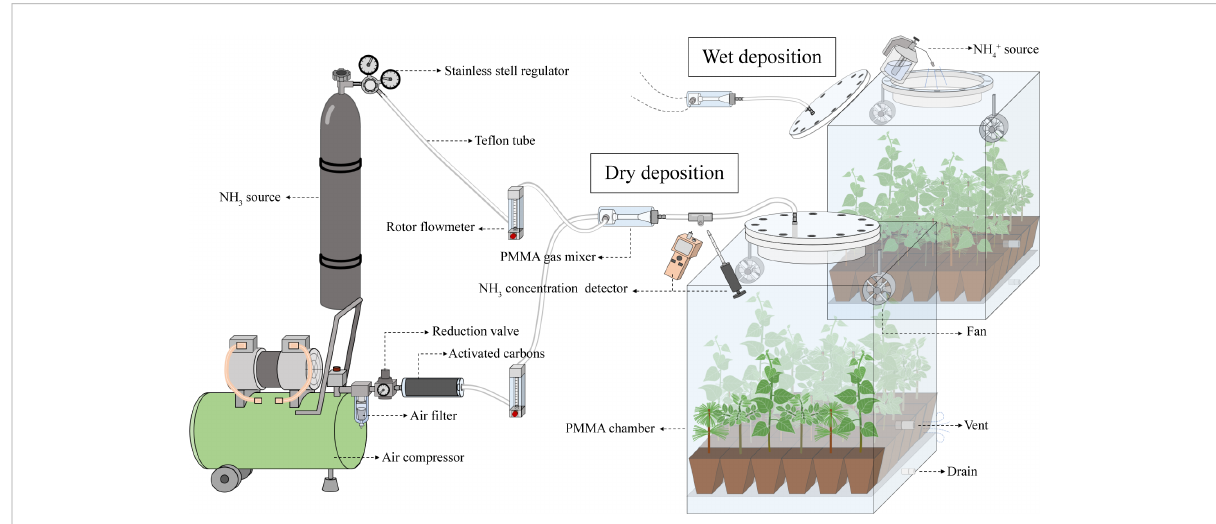
FIGURE 1 A schematic diagram showing the materials used to simulating dry and wet N deposition The ambient air compressed by the air compressor is pumped into the chamber from the top of the chamber after passing through the reduction valve, activated carbons, rotor fl owmeter and gas mixer in turn. NH 3 is injected into the gas mixer from a cylinder and mixed with the pumped air, and adjusted to the desired concentration by rotor fl owmeter to simulate dry deposition. The top of the chamber consists of a fl ange interface that can be opened and used to simulate wet deposition. PMMA, polymethyl